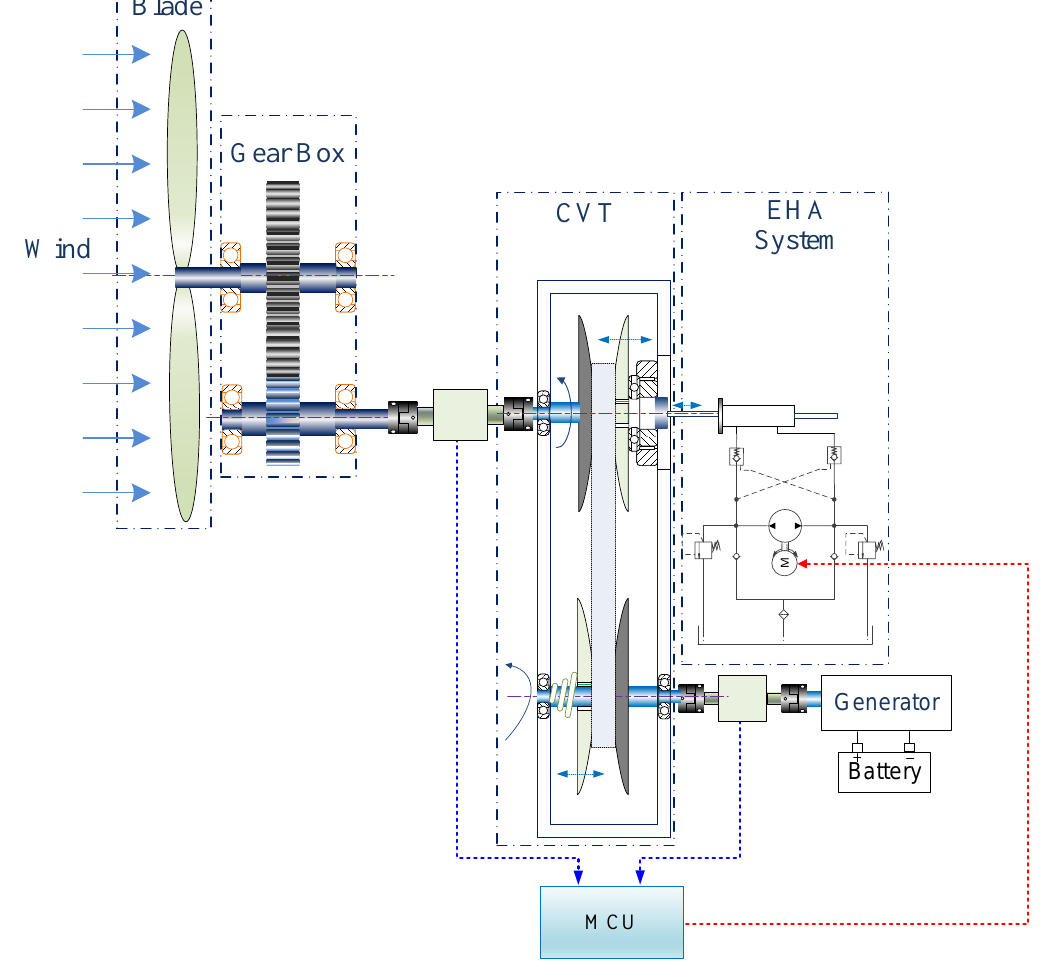
Figure 1. Configuration of experiment test rig.